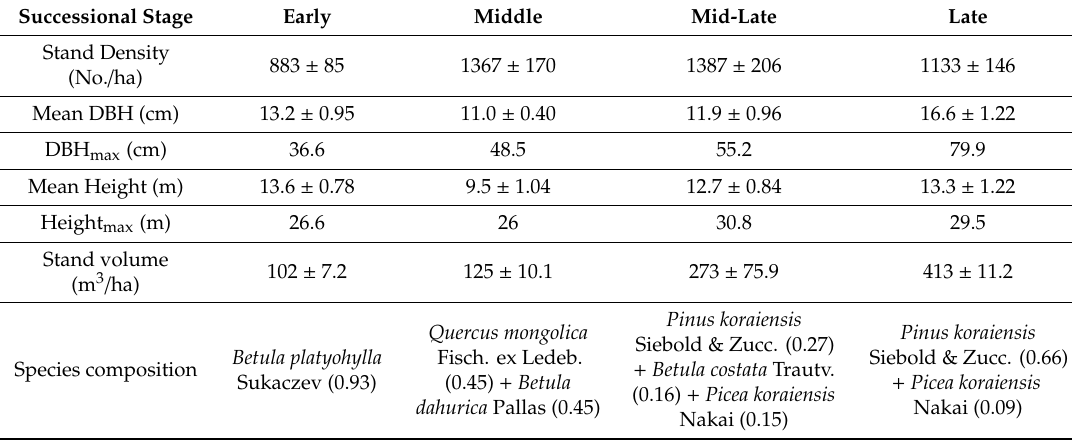
Table 1. Characteristics of the twelve stands of four successional stages at the Shengshan Reserve in Heilongjiang province, China (mean ± within